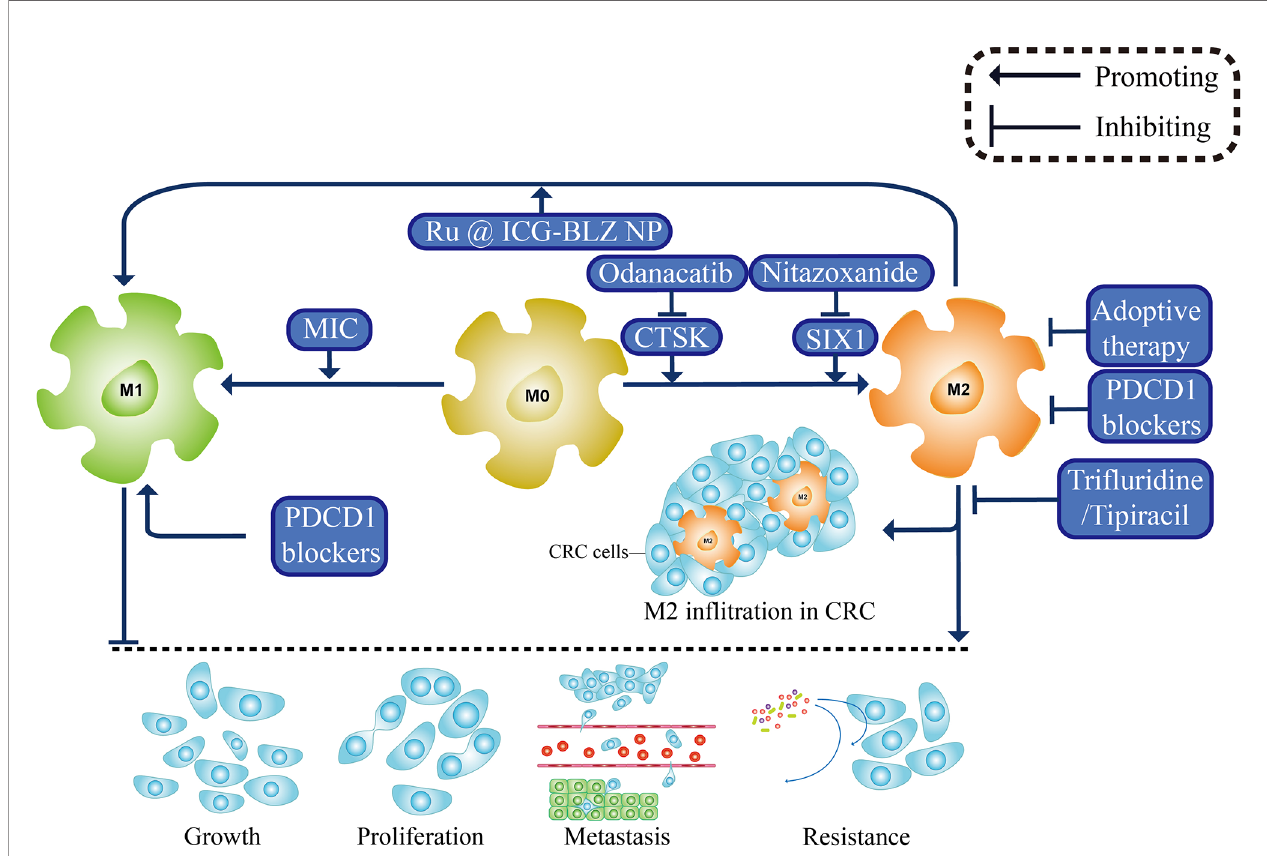
FIGURE 3 | Treatments based on TAMs. M0 macrophages polarized towards M1 or M2 phenotypes to participate in growth, proliferation, metastasis, and drug resistance of CRC. Therefore many treatments are designed based on the polarization of TAMs. Odanacatib and Nitazoxanide, targeting CTSK and SIX1 respectively, both inhibit the alternative activation of undifferentiated macrophages, and MIC triggers the polarization of M1 macrophages. Meanwhile, nanoscale drug Ru @ ICG-BLZ NP can directly induce the conversion of M2 phenotype to M1 phenotype, showing a new method for clinical transformation. The role of cholesterol metabolism in CRC is gradually being valued, and a new anti-metabolism drug Tri fl uridine/Tipiracil was shown to weaken in fi ltration of M2 macrophages. Other therapy such as PDCD1 blockers and adoptive cell therapy could also act on TAMs and showing anti-tumor